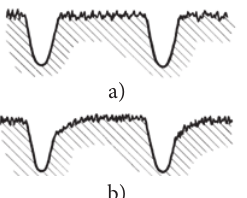
Fig. 11. Wear of the edge of a micro groove: a) before operation; b) after 1500 hours of operation